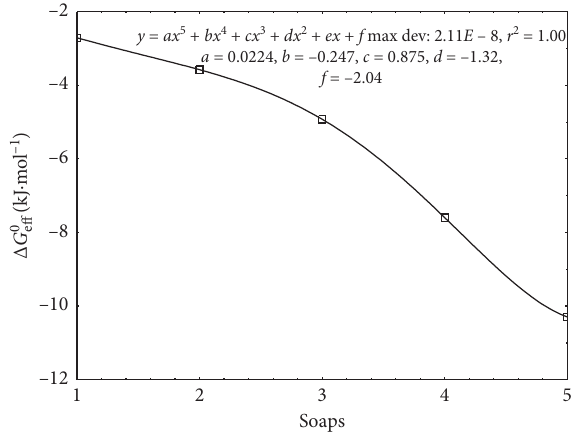
Figure 13: Variation of Δ G o